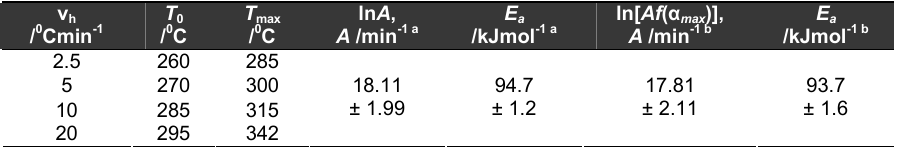
Table 1 – Values of T 0 , T max and corresponding kinetic parameters obtained by Kissin- ger’s (Eq. (2)) and stationary point (SP) (Eq. (6)) methods, at different heating rates for the non-isothermal reduction process of NiO under hydrogen